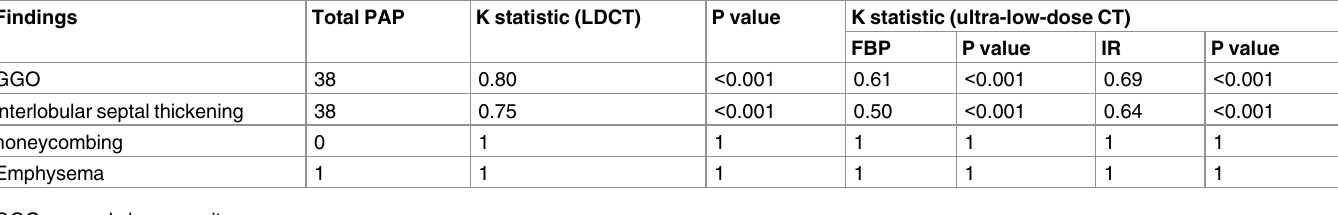
Table 2. Diagnostic confidence in CT findings from patients with PAP in LDCT and ultra-low-dose CT.